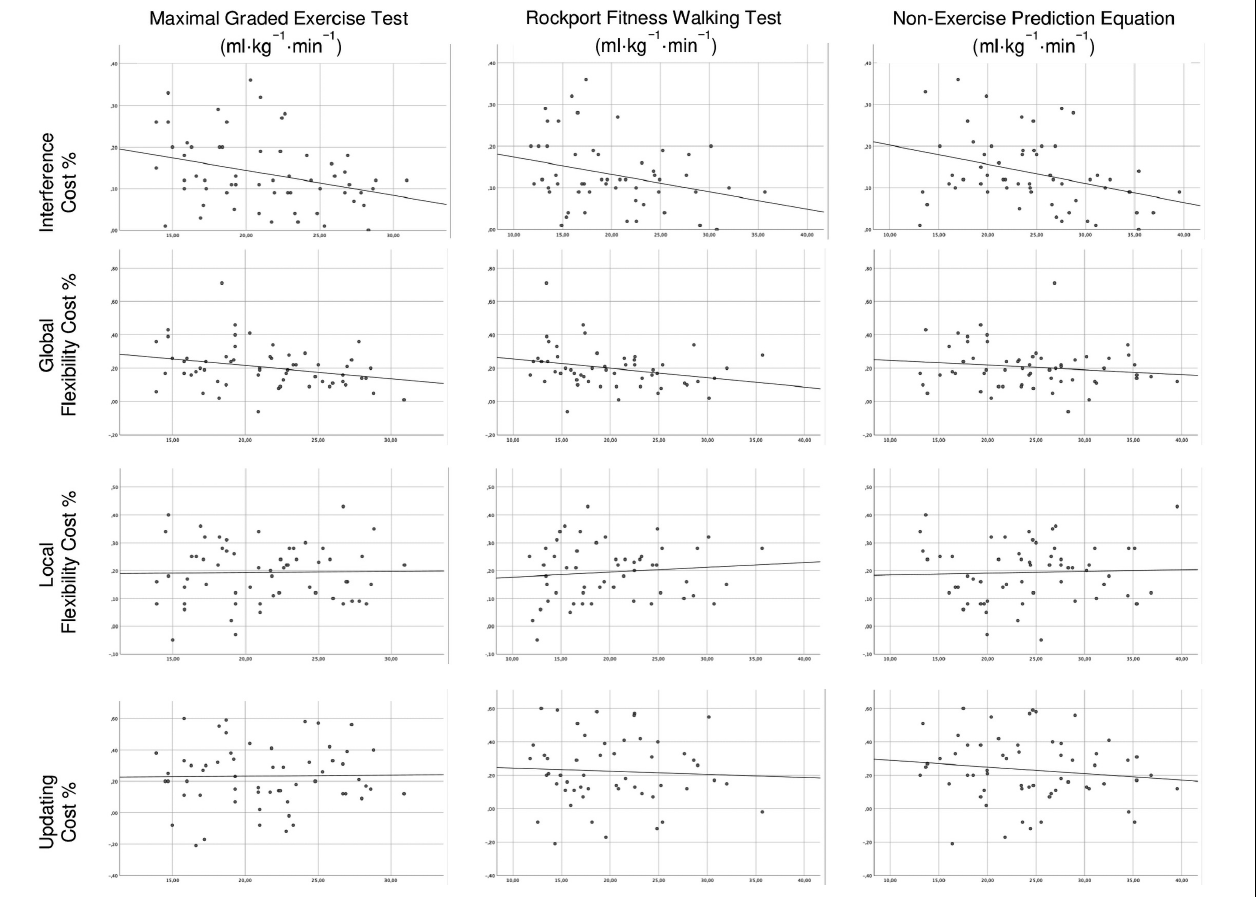
FIGURE 3 | Scatter plots of the associations between cardiorespiratory fitness estimates and executive functions